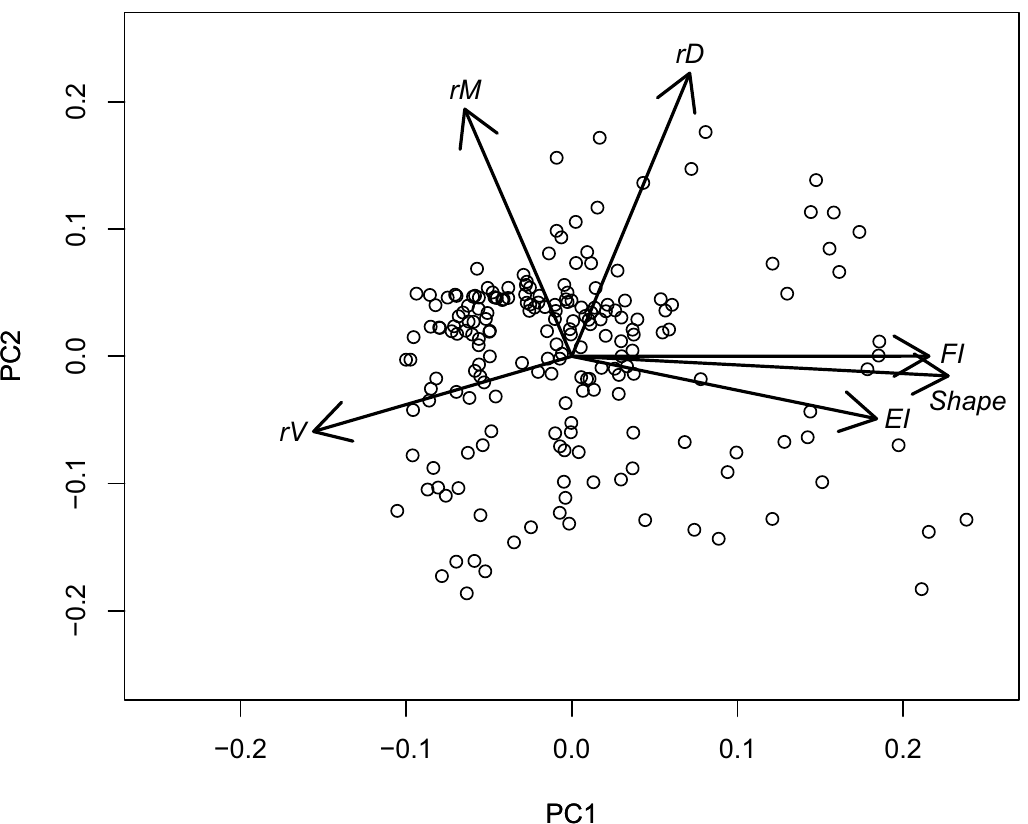
Figure 4. Principal component analysis in variation in seed form across species of seed and year after burial ( YAB ). PC1 and PC2 together explain 75.7% of the variance. Symbols indicate combination of seed species and YAB